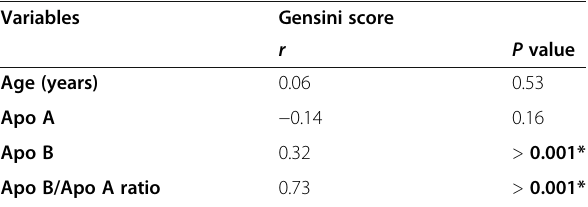
Table 6 Correlation between Gensini score and other variables in the studied patients Variables